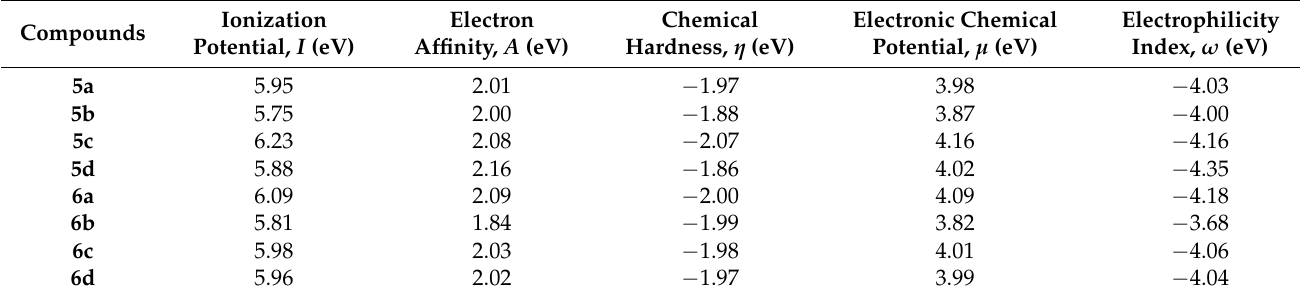
Table 2. Reactivity descriptors ( I , A , η , μ , ω ) of the synthesized analogues compounds under study.